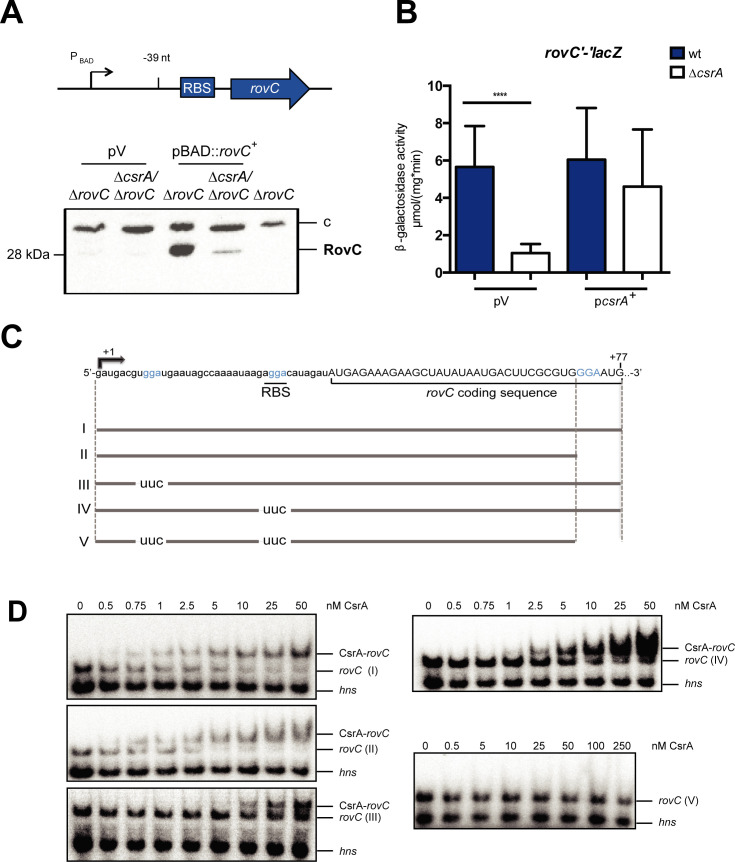
CsrA directly interacts with the rovC transcript.(A) RovC protein amounts were monitored in the Y. pseudotuberculosis ΔrovC strain (YP154) and the ΔcsrA/ΔrovC double mutant (YP318). Both strains were transformed with the empty vector pBAD30 (pV) or the inducible rovC+ overexpression plasmid pVK25 (pBAD::rovC+). The promoter was induced by addition of 0.1% arabinose. Whole cell extracts were prepared from strains grown overnight at 25°C, separated on 15% SDS gels and transferred onto a PVDF membrane. Proteins were detected by immunoblotting using a polyclonal RovC antibody. The ΔrovC mutant strain served as negative control and a detected unspecific band was used as loading control. (B) Expression of a translational rovC’-‘lacZ reporter fusion (pVK43) was monitored in the Y. pseudotuberculosis wild type strain (YPIII) and the ΔcsrA mutant (YP53). Both strains were transformed with the empty vector pAKH85 (pV) or complemented with the csrA+ plasmid pAKH56 (pcsrA+). β-galactosidase activity (μmol/mg.min) was measured in strains grown over night at 25°C. The data represent the mean ± standard deviation of three independent experiments, carried out in triplicates. Data were analyzed by Student’s t-test; ****P < 0.0001. (C) Schematic representation of the in vitro transcribed rovC mRNA fragments. The three GGA-motifs within the RNA fragments are highlighted in blue, the transcriptional start site is labeled with +1 and the end of the fragment with +77. The RBS and start of the rovC coding sequence are underlined. Fragments containing varying length of the rovC mRNA are labeled with roman numerals ranging from I to V. All substitutions of GGA-motifs within the fragments are indicated as ‘uuc’. The fragments range from +1 to +77 or from +1 to +71; they are depicted by grey lines below the rovC mRNA sequence. (D) EMSAs with RNA fragments I to V show direct binding of the CsrA protein to the rovC transcript. The hns transcript was used as negative control. The RNAs were incubated with increasing concentrations of purified CsrA ranging from 0 to 50 nM (I—IV) or 0 to 250 nM (V).